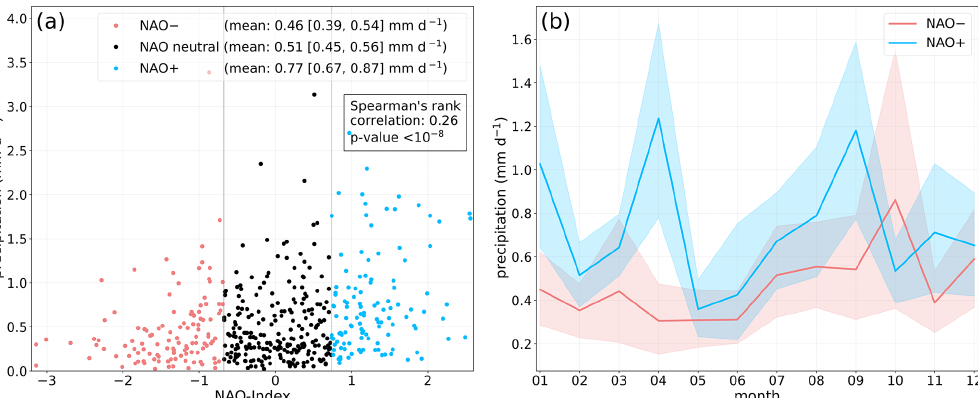
Figure 9. (a) Scatterplot of precipitation in study region against the NAO index for in total 460 months (February 1979–May 2017). Months were separated into months with NAO indices below or equal to the 25th percentile (NAO − ), above or equal to the 75th percentile (NAO + ), or in between the 25th and 75th percentiles (NAO neutral). (b) Mean annual cycle of precipitation in study region for months with NAO being below or equal to the 25th percentile (NAO − ) and above or equal to the 75th percentile (NAO + ). For each month of the year, month-specific 25th and 75th percentile thresholds were computed. The shaded areas represent the 95% confidence interval of the mean.